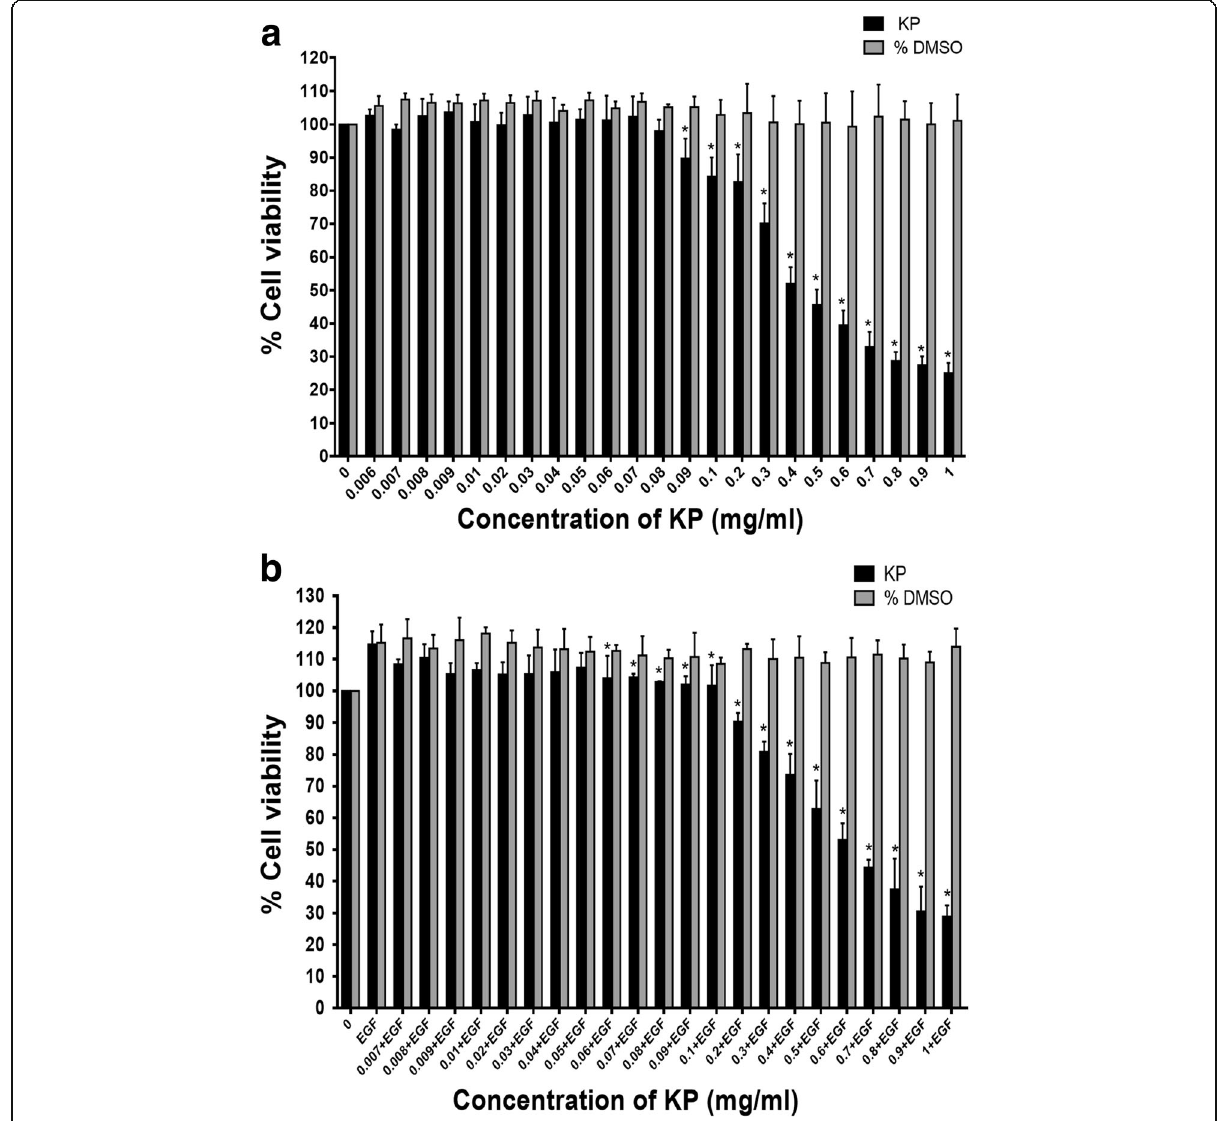
Fig. 1 The cytotoxicity effect of different concentrations of KP ethanol extract on SKOV3 cells without EGF ( a ) and with 100 ng/mL EGF ( b ). All data were from 3 independent experiments and reported as means ± SD of each quadruplicate * P <0.05 compared to the control (untreated and